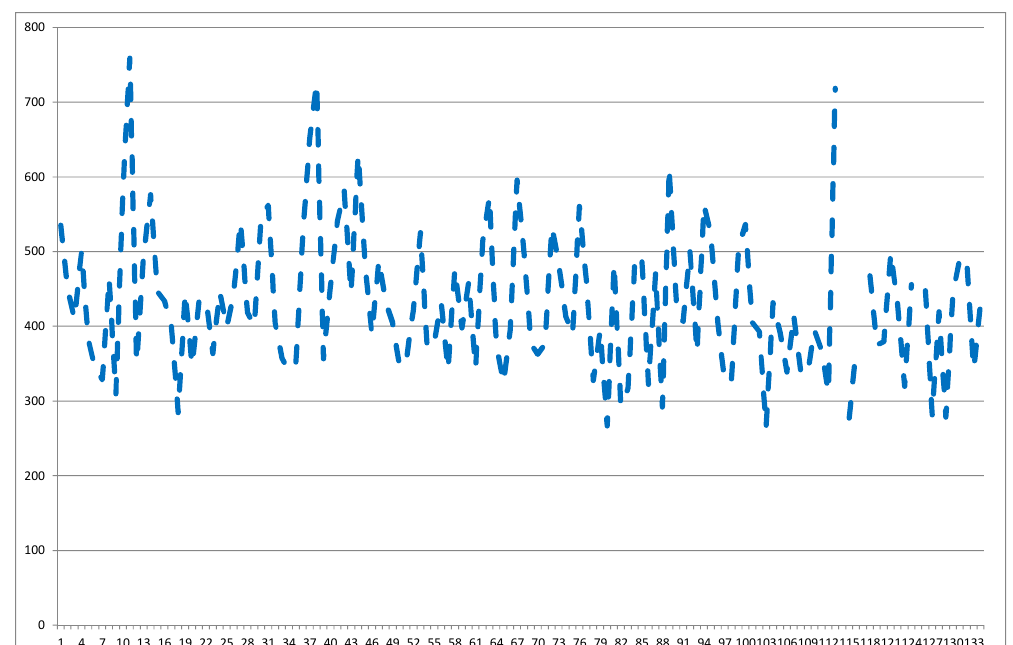
Figure 9. Annual rainfall totals for Minlaton, 34 . 77 ◦ S, 137 . 60 ◦ E, for 1880–2013. Note that exponential smoothing was not done for this location as there are some missing